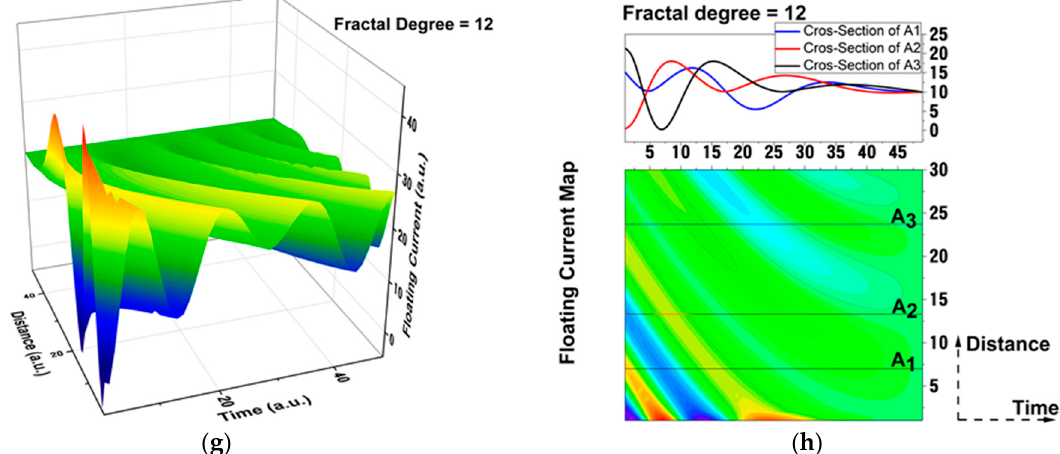
Figure 6. Space–time maps (1-( a ); 3-( c ); 8-( e ); 12-( g )) of the floating current in 3D and contour plot representations (1-( b ); 3-( d ); 8-( f ); 12-( h )) for various fractalization degrees (1, 3, 8, 12).